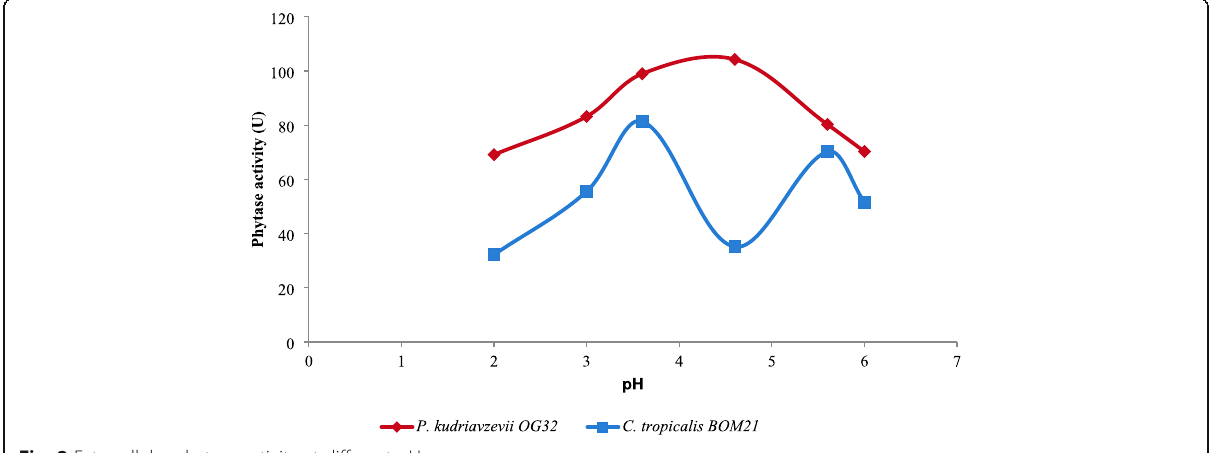
Fig. 2 Extracellular phytase activity at different pH